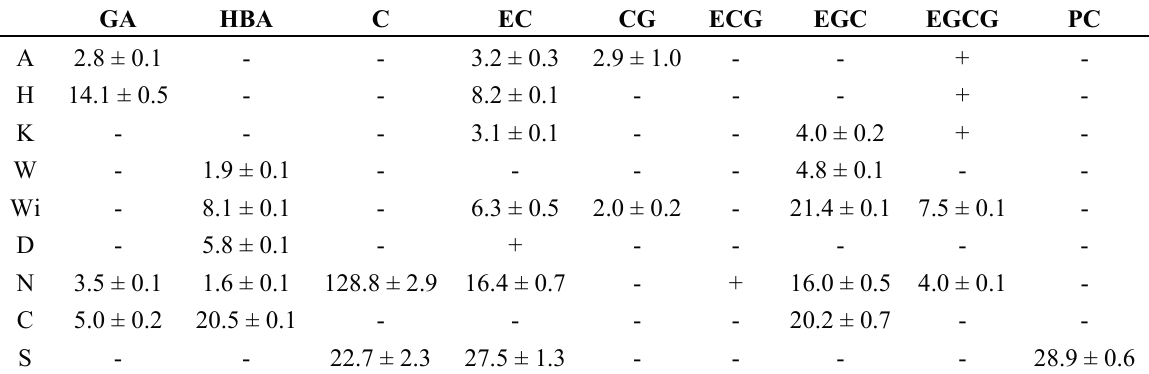
Table 2. Amounts ( μ g·g − 1 sample) of selected phenolic compounds (GA—gallic